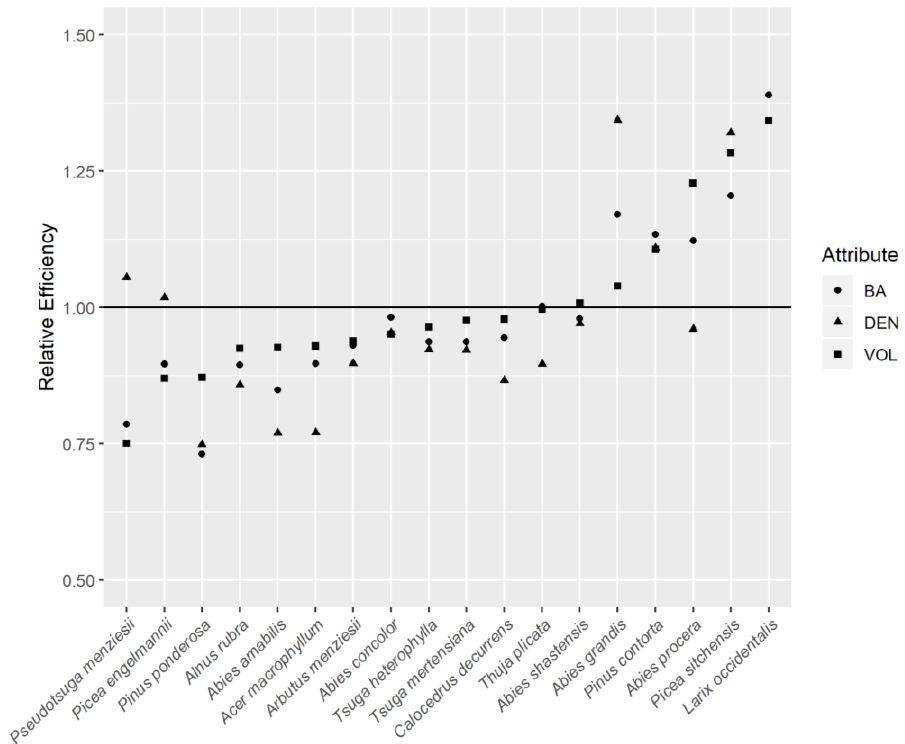
Figure 3. Relative efficiency of the post-stratified point estimator to the Horvitz-Thompson estimator for each species-specific attribute. Species are ordered in ascending order from left to right by their relative efficiencies for the VOL attribute.